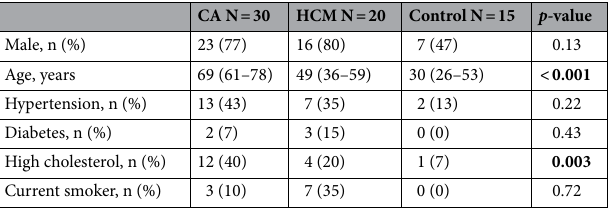
Table 1. Patient characteristics. Bold values indicate significant p -value <